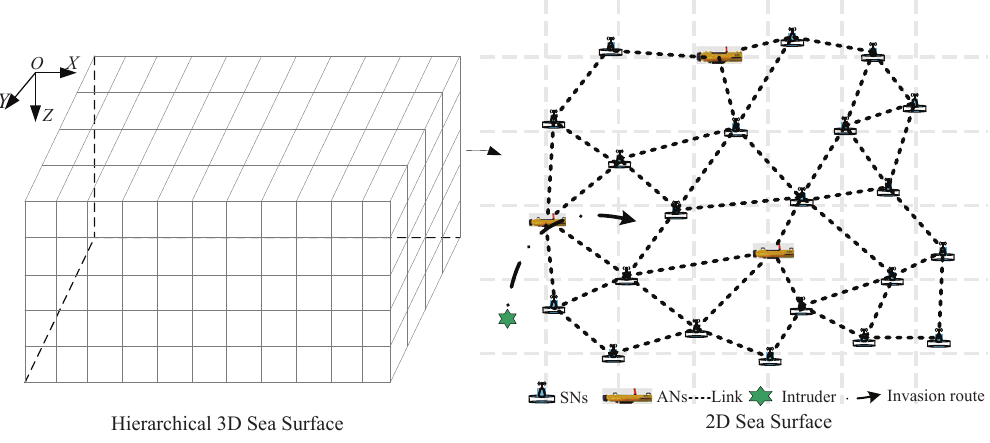
Figure 1. The intrusion detection over actuator-assisted underwater sensor